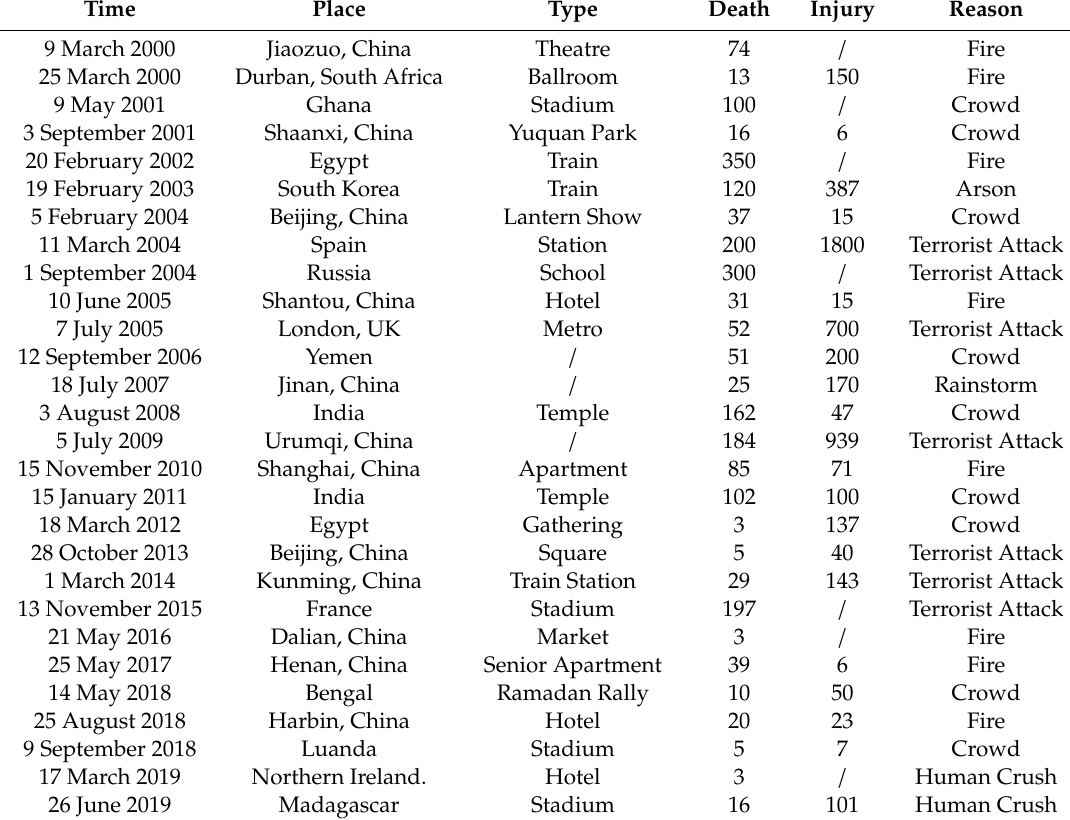
Table 1. Statistical results of casualty incidents in the Urban Large-scale Public Spaces (ULPS) across the world (2000–2018)